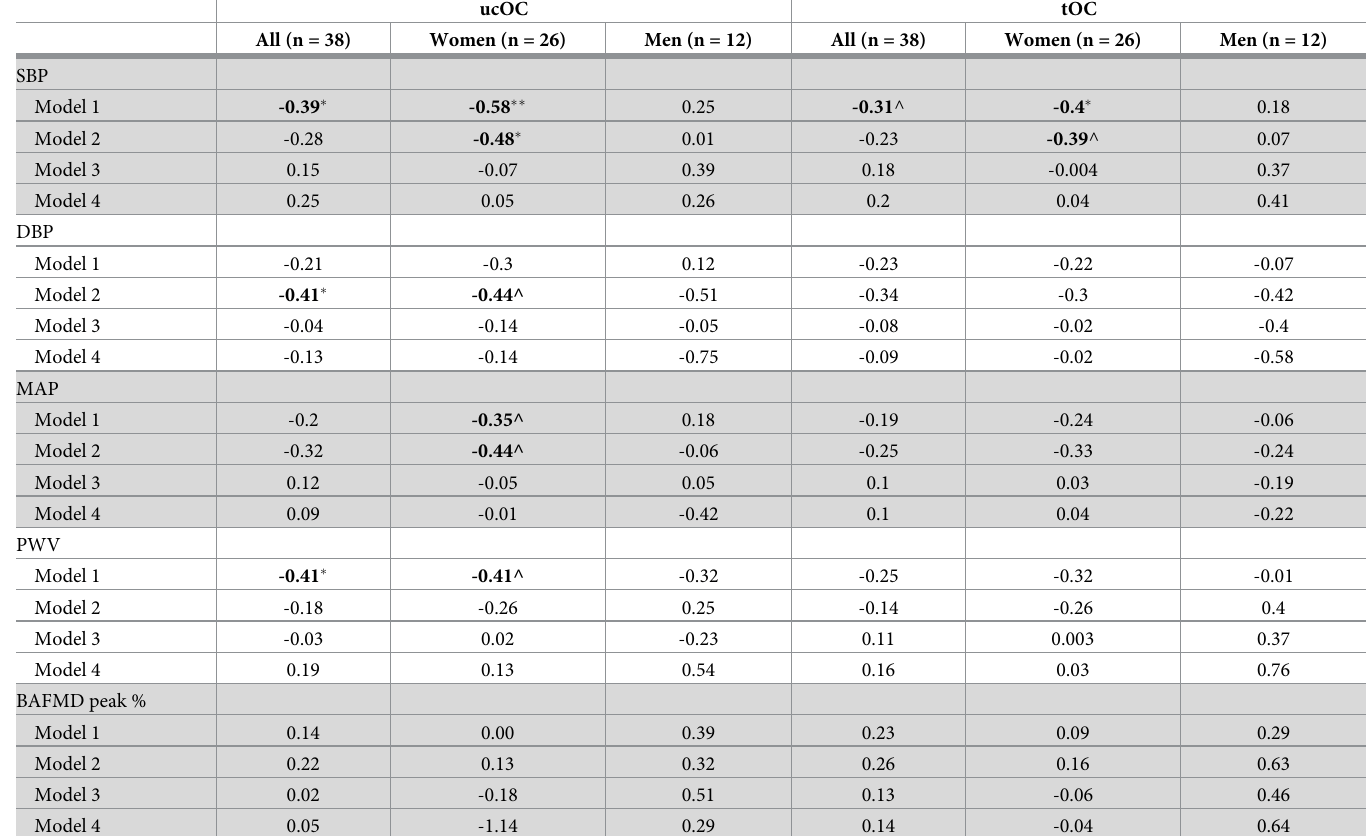
Table 2. Correlation of ucOC and tOC with vascular function